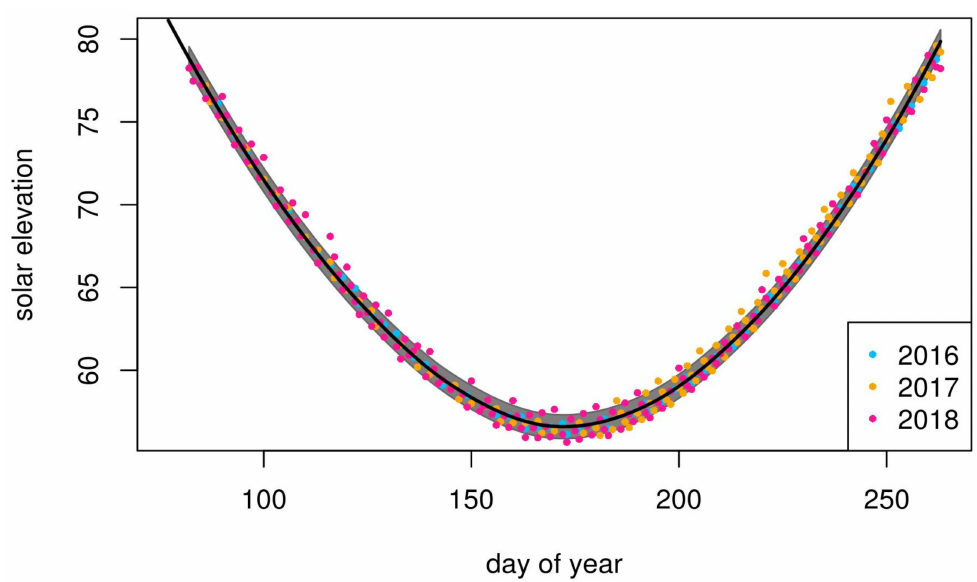
Figure A1. Average solar elevation for all granules at the time of sensing by S-2 for each day coverage of the whole AOI could be retrieved. Black line is the mean smoothed by local regression; all circle centers in the gray area fall within one standard deviation from the mean. Minimum solar elevation is 79.6 ◦ from nadir on 19 September 2017; maximum is 55.7 ◦ from nadir on 22 June